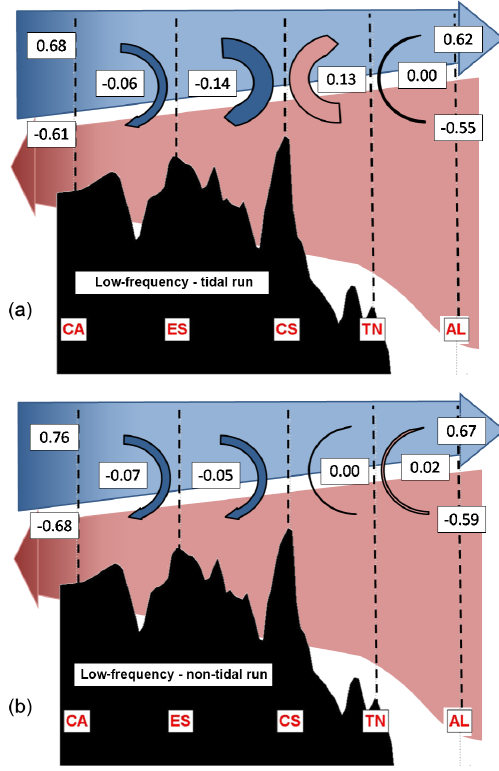
Figure 8. Two-layer diagram to explain the low-frequency transport divergence associated with tides in each layer. (a) Mean exchange obtained for the tidal run. (b) Mean exchange for the non-tidal